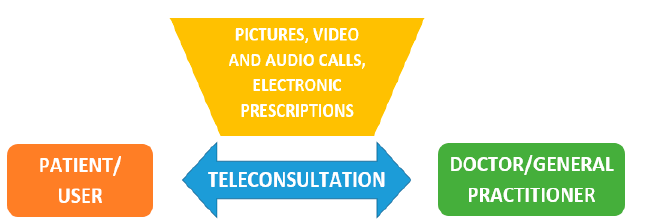
Figure 1. General telemedicine organizational chart which involves bi-directional information exchange between the patient and the doctor. Most laboratories from Romania restrict the practice of sending the results via e-mail to the patient due to the General Data Protection Regulation (GDPR). For this fact, they choose to print the validated results file and deliver it stamped and signed to the patient in physical form.